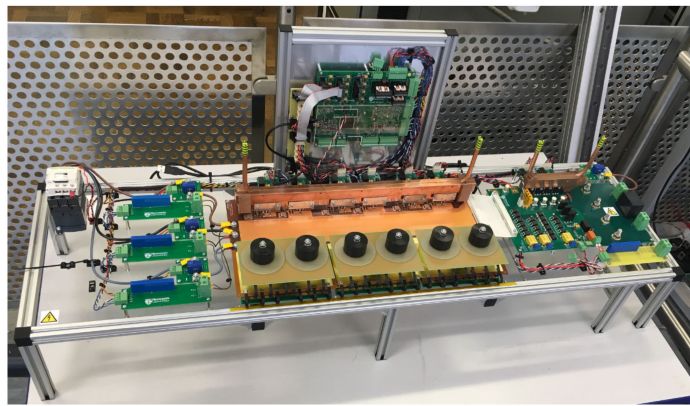
Figure 10. Current source converter laboratory